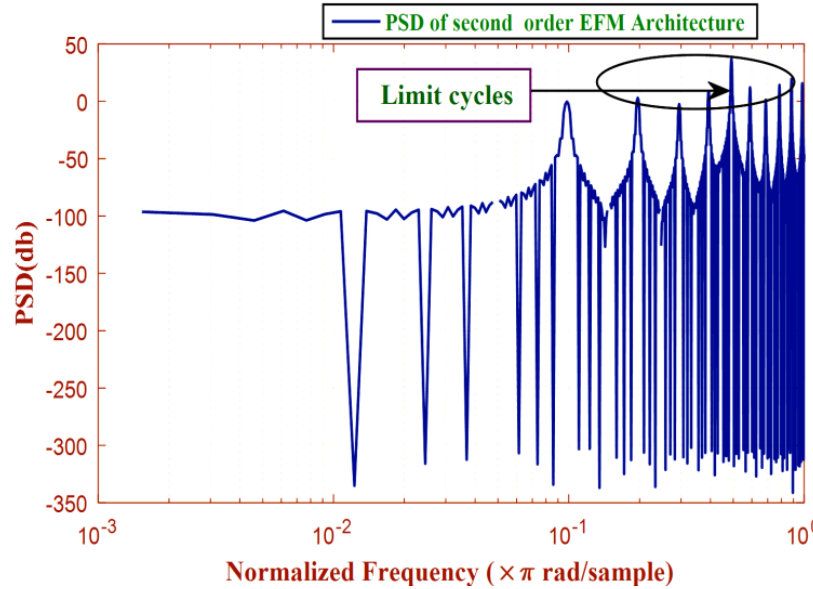
Figure 4. PSD of Second Order EFM with OSR = 64.